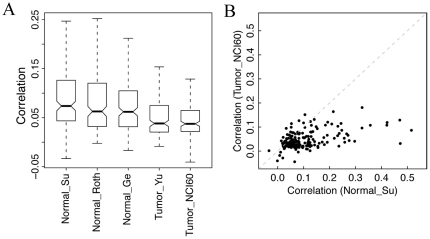
Reduced correlations of expression profiles for genes in the same pathways.For each of the 186 KEGG pathways, the average Spearman correlation coefficient was calculated across all pairs of genes in the pathway. (A) Distributions of the average correlations of the 186 pathways. (B) Average correlations of the 186 pathways in normal tissues and NCI-60 cell lines. Note most of the pathways show stronger gene co-expression in normal tissues than in cancer cell lines.